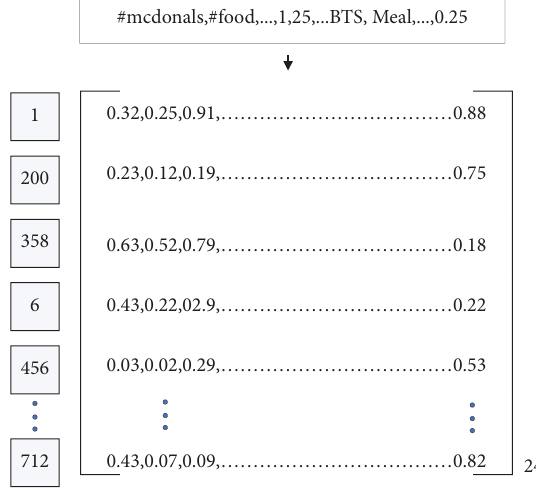
Figure 6: Feature